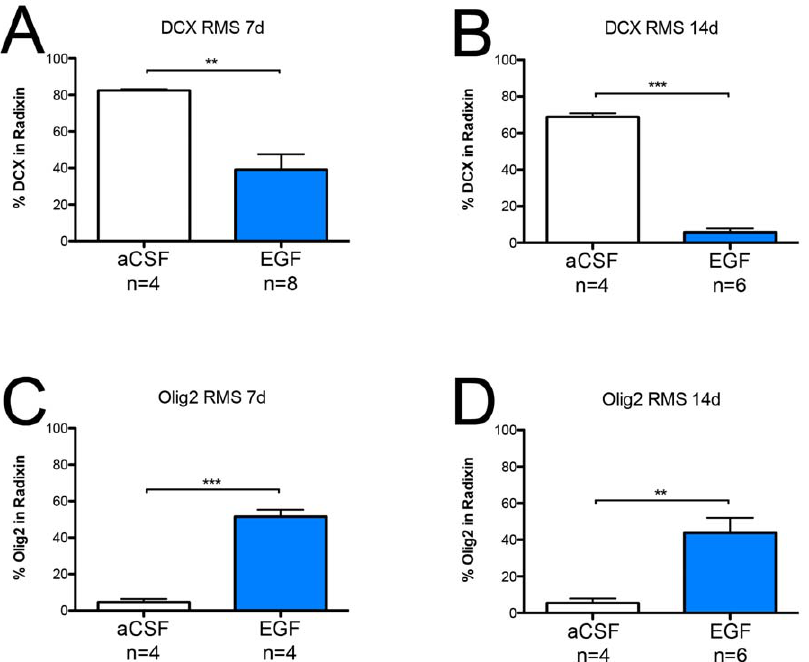
Figure 5. Olig2 and doublecortin expression in radixin + cells. Graphs visualizing the percentage of cells ( 6 SEM) expressing doublecortin (DCX) or Olig2 in radixin + cells within the rostral migratory stream (RMS) ( A, C ) after 7 days and ( B, D ) after 14 days of EGF infusion. Statistical significance was assumed at ** p , 0.01 and *** p , 0.001 using Student’s t-test.